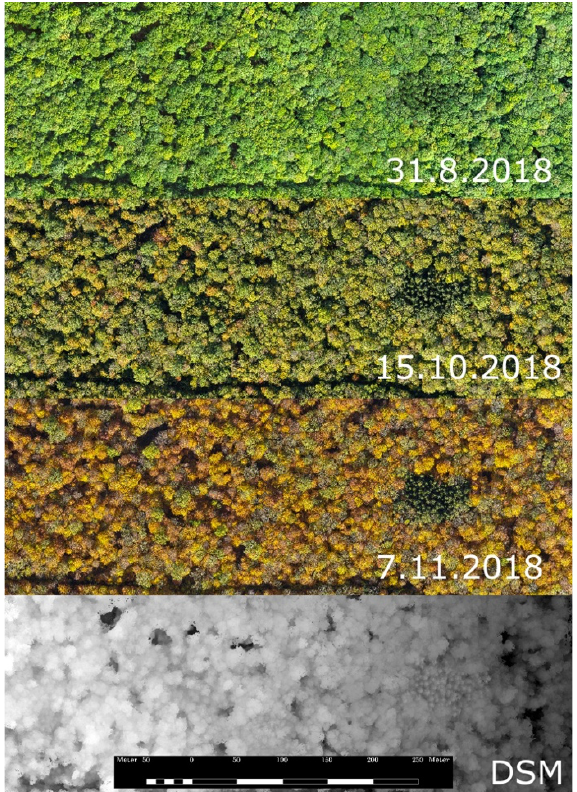
Figure 2: Subset of the study area with RGB spectral properties (uncalibrated) from 31.8., 15.10. and 7.11.2018 and digital surface model (DSM) below.